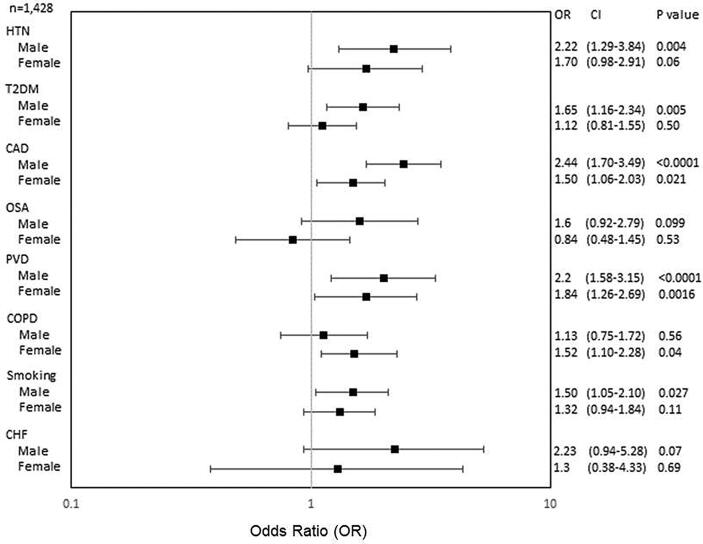
Impact of age-adjusted AF risk factors on stroke in non-Hispanic blacks (NHBs). Abbreviations: CI, confidence interval; HTN, hypertension; T2DM, type II diabetes mellitus; OSA, obstructive sleep apnea; COPD, chronic obstructive pulmonary disease; CHF, congestive heart failure; TIA, transient ischemic attack.